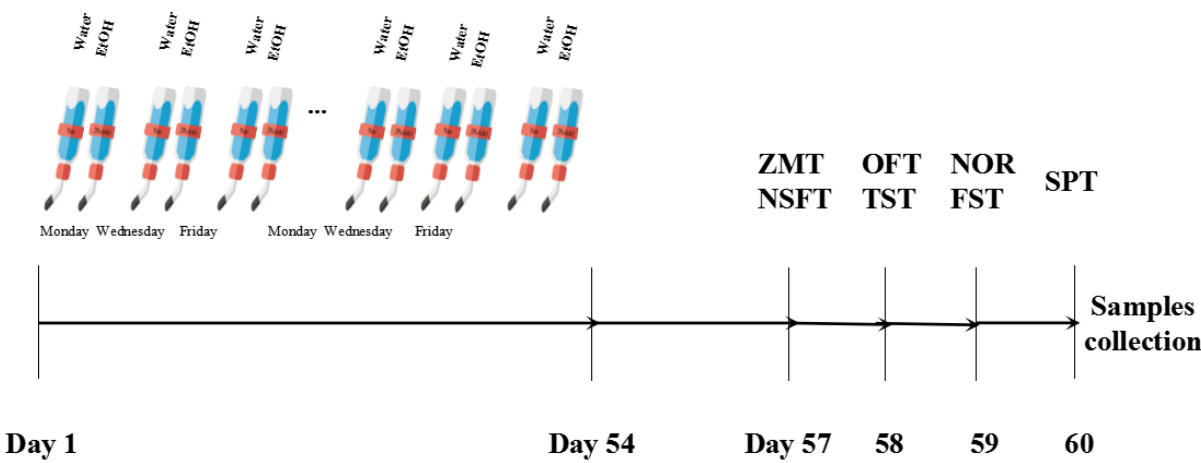
Figure 9. Schematic of the experimental timeline for alcohol drinking and behavioral testing.